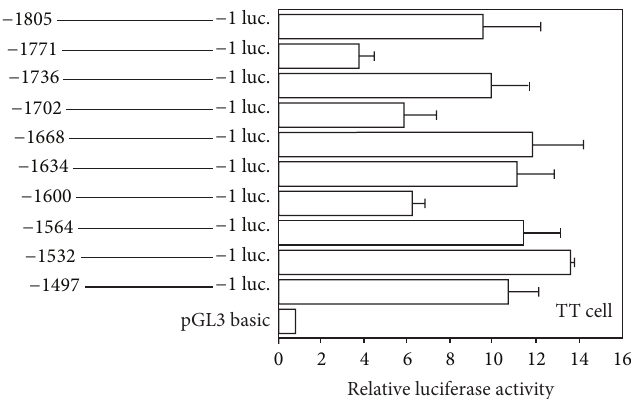
Figure 3: Deletion analysis of the human ghrelin promoter. Relative luciferase activity in the area of − 1805 to − 1497 of the human ghrelin promoter was examined. Plasmids containing the human ghrelin promoter sequence ligated to the firefly luciferase were transiently transfected into TT cell. The schematic diagram represents the human ghrelin promoter activity in the each deletion constructs. Relative luciferase activity was the ratio of luciferase activity cotransfected with each expression vector versus pGL3 basic vector. The data represent the mean ± SE for triplicate samples. Statistically significant differences were calculated by relative luciferase activity in the area of − 1805 to − 1 as the standard. Asterisks indicate the differences between each group ( 𝑃 < 0.05 ).